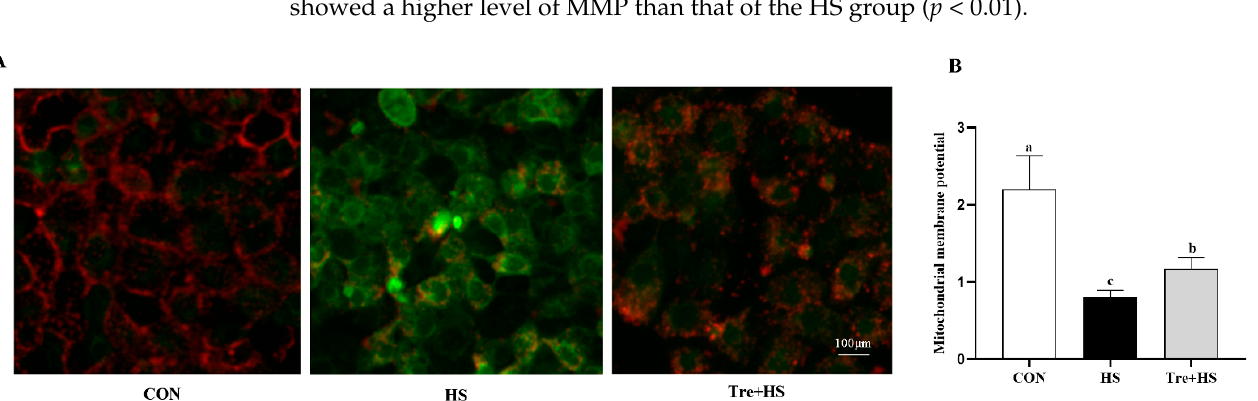
7 of 13 Figure 3. Effects of trehalose on endoplasmic reticulum stress (ERS) response in heat ‐ stressed IPEC ‐ J2 cells. IPEC ‐ J2 cells were cultured at 37 °C until the end of the experiment (control, CON); exposed